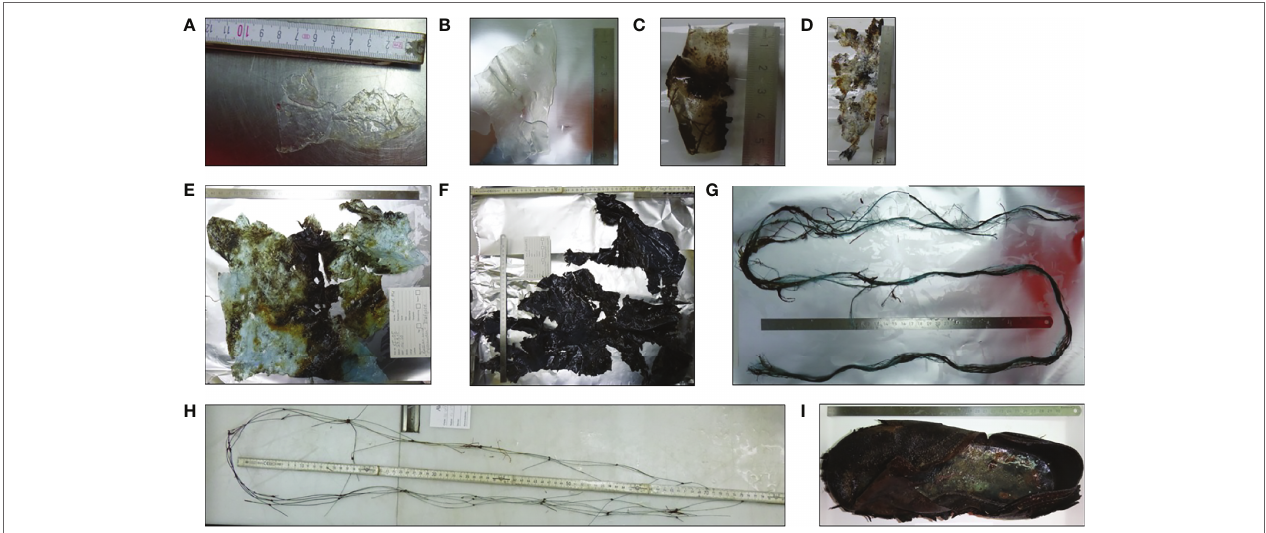
FIGURE 5 | Photographs of debris items found in pelagic and bottom trawls during RV Heincke expedition around Svalbard in 2015. (A) Transparent plastic fragment secured from a jellyfish caught at 56 m depth in the Hinlopen Strait; (B–H) plastic debris collected from fish lift samples taken above the seafloor of Billefjorden; (I) weathered leather shoe collected by a bottom trawl in